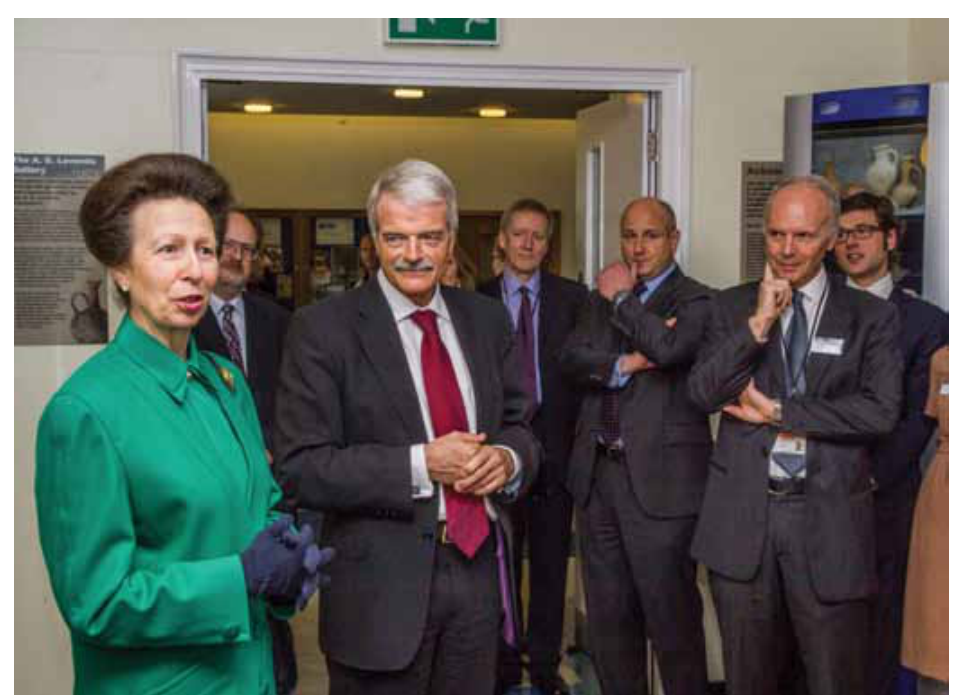
Fig. 1: The Princess Royal, Chancellor of the University of London, visiting the Institute dur- ing its 75th anniversary